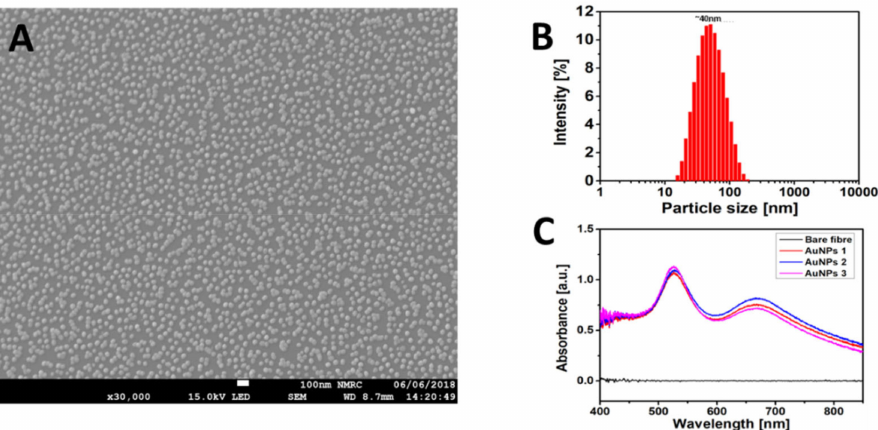
Figure 4. ( A ) SEM of Au NP coating on the optical fibre surface with a scale of 100 nm. ( B ) Size distribution of Au NPs obtained via dynamic light scattering (DLS). ( C ) Absorption spectra of optical fibre before and after Au NPs. Three optical fibres were coated to investigate repeatability of the coating